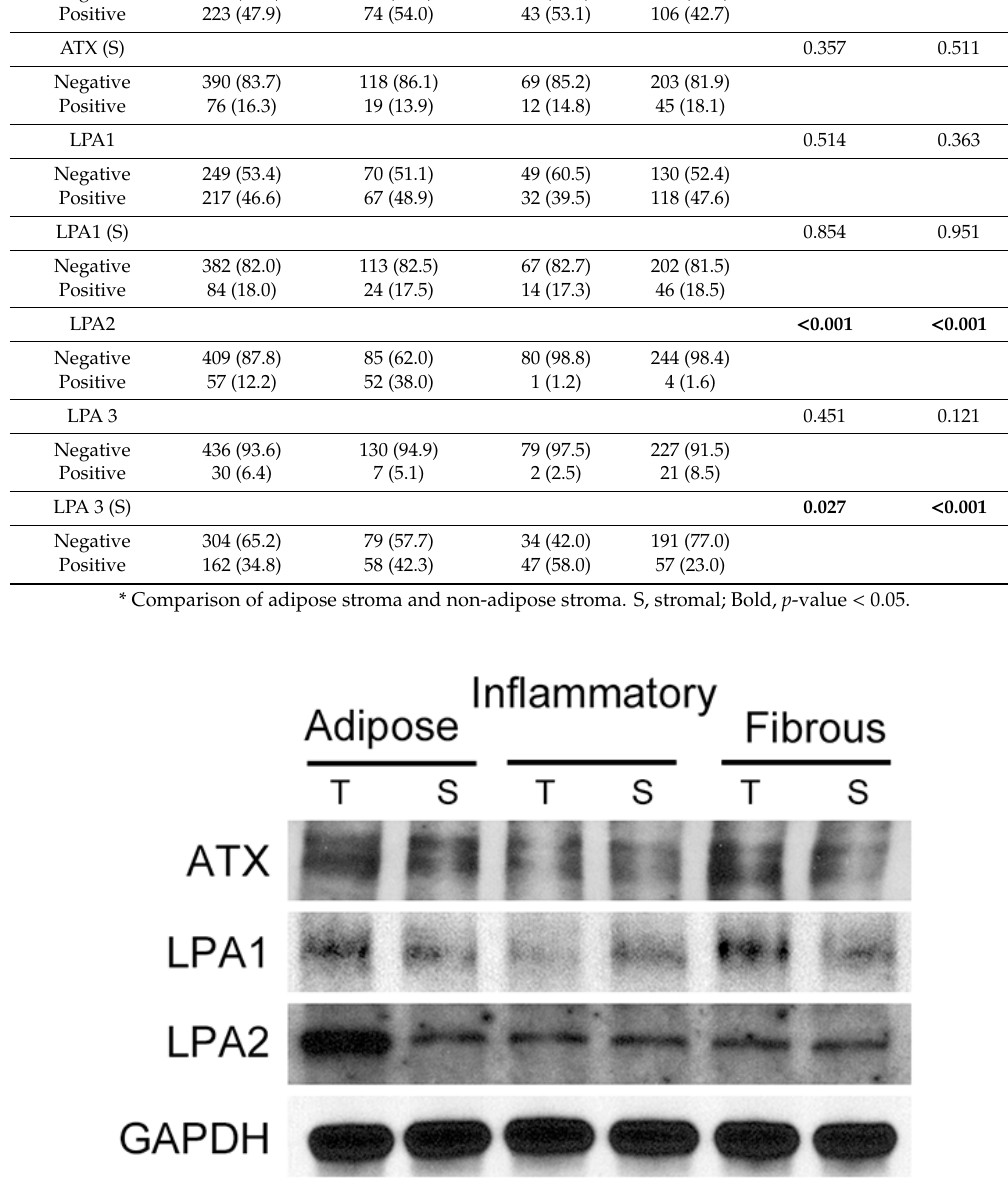
Table 4. Correlation among the expression of ATX-LPA signaling-related proteins. Parameters